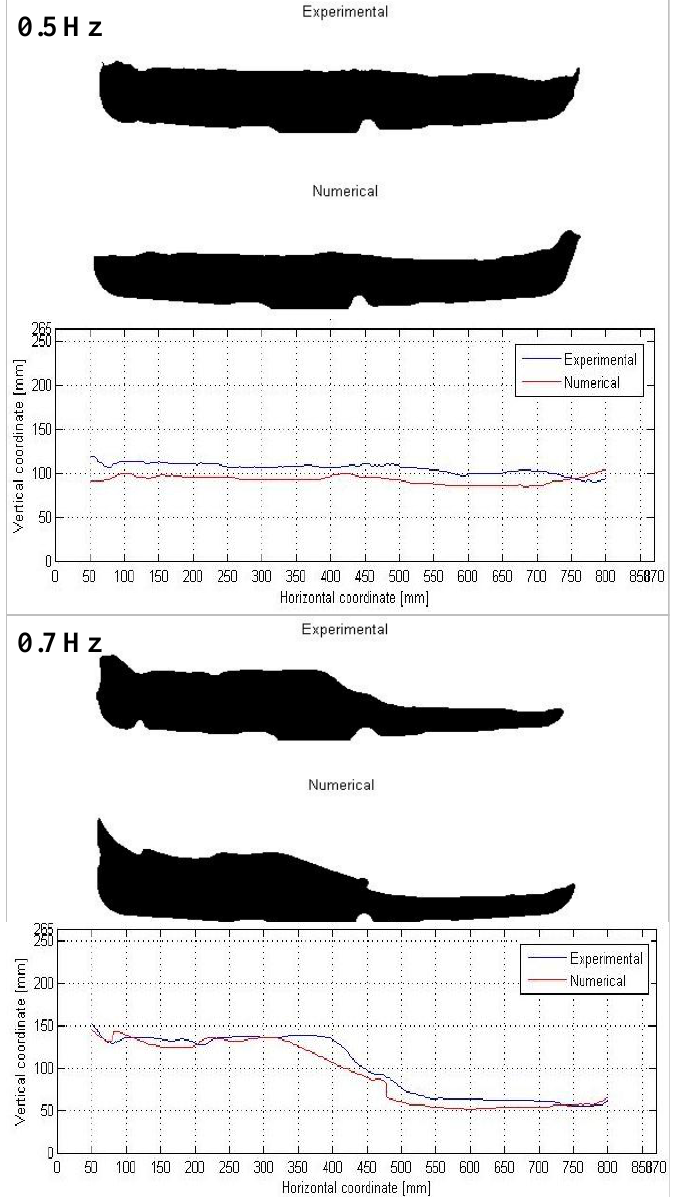
Figure 15. 2D Comparison of the free surfaces—numerical vs. experimental data. The mean deviation standard in Table 5 for a frequency of 0.5 Hz is 12.0 mm with a final error percentage of 4.2% while for the frequency of 0.7 Hz the deviation standard is 16.2 mm with a final error percentage of 5.9%. As said, the average error percentage is calculated, with steps of 0.25 s, from the standard deviation compared to the height of the